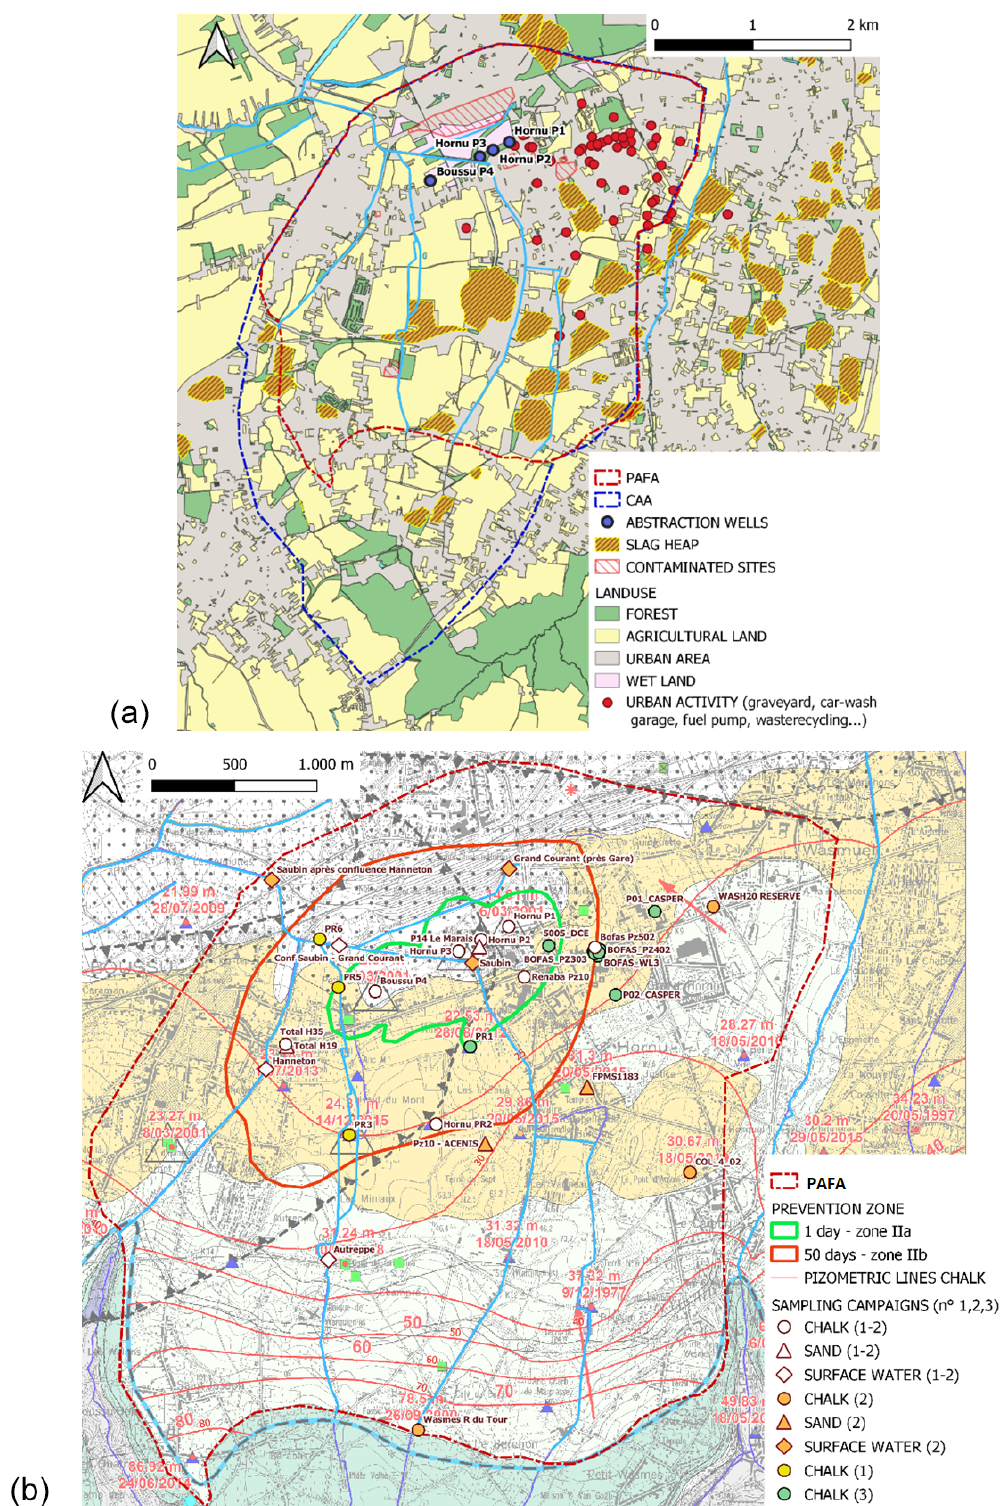
Figure 3. (a) Map of all potential contamination sources present in the investigated site (© WalOnMap), (b) Monitoring network of sampling points for the three different campaigns performed, prevention zones and chalk aquifer pizometry (background map: Carte Quiévrain –